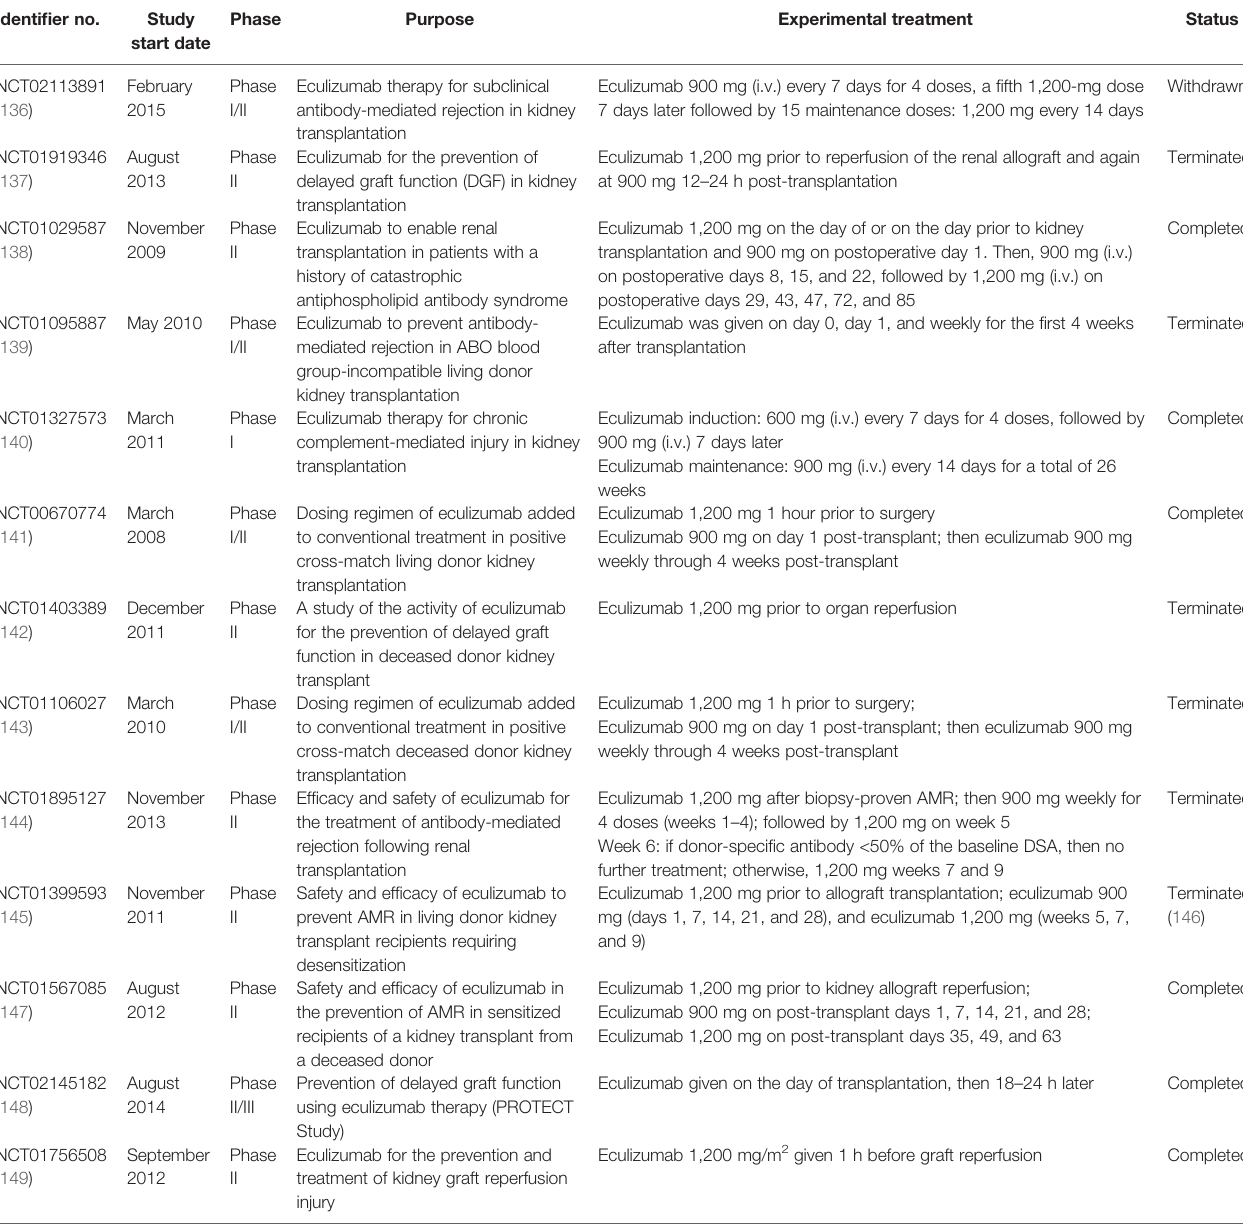
TABLE 2 | Clinical trials of eculizumab in kidney transplantation. Identi fi er